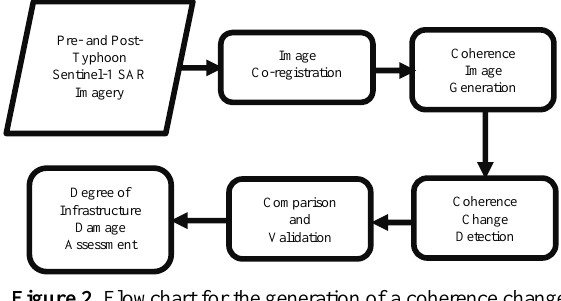
Figure 2 . Flowchart for the generation of a coherence change layers from Sentinel-1 images through Coherence Change Detection as basis for analyzing the infrastructure damage